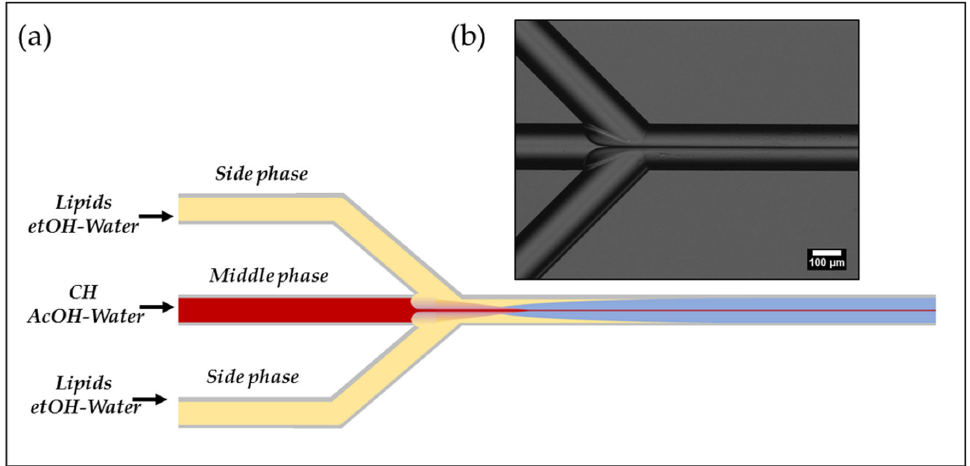
Figure 1. Schematic illustration of microfluidic experimental set-up: ( a ) Qualitative illustration of coupled Hydrodynamic Flow Focusing (cHFF) strategy processed in the microfluidic device; ( b ) Transmission Optical Microscopy Image of Hydrodynamic Flow Focusing (HFF) pattern.